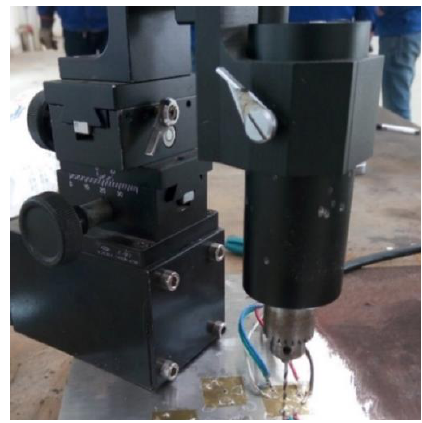
Figure 9. High-speed drilling machine HTZ–12S.